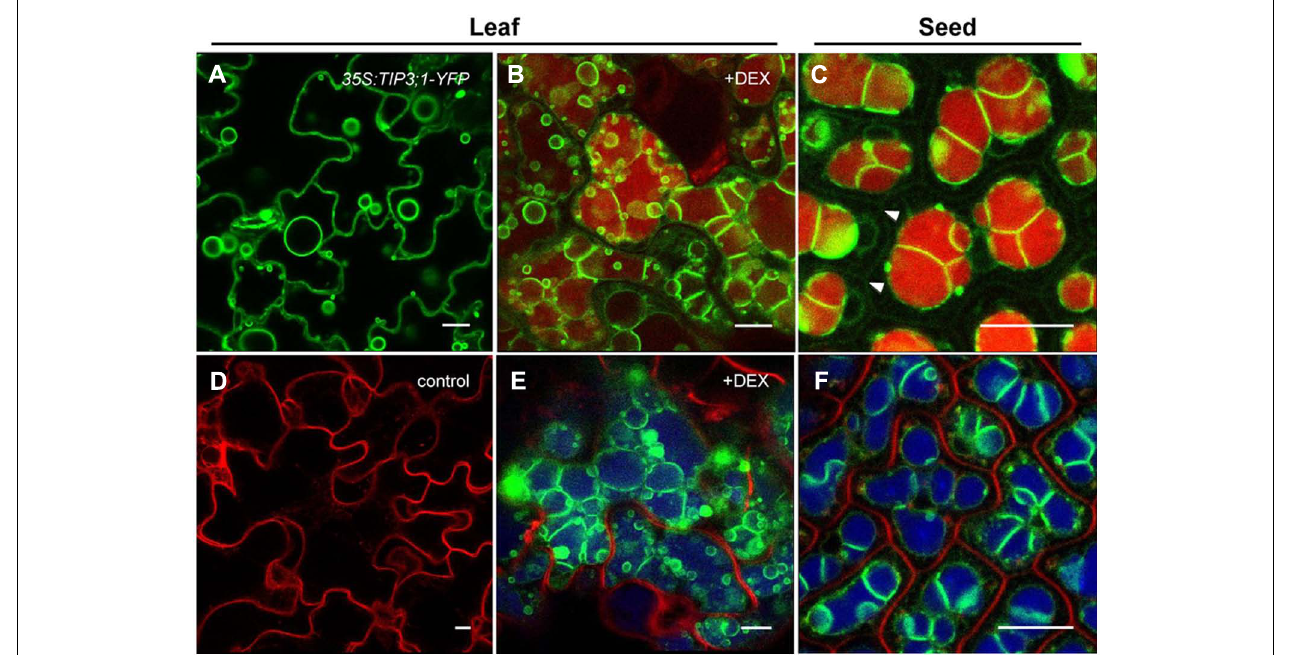
FIGURE 2 | Formation of PSV-like organelles in leaves overexpressing LEC2 . Leaf epidermal cells from 35S:LEC2-GR plants co-expressing TIP3;1:TIP3;1-YFP and TIP1;1:TIP1;1-RFP ( LEC2/TIP3-YFP/TIP1-RFP ; Feeney etal., 2013) incubated on DEX to induce LEC2 expression (B,E) are compared to LEC2/TIP3-YFP/TIP1-RFP plants grown without DEX (D) or leaves of seedlings constitutively expressing 35S:TIP3;1-YFP (A) . Leaf cell morphology is compared with cotyledonary cells of